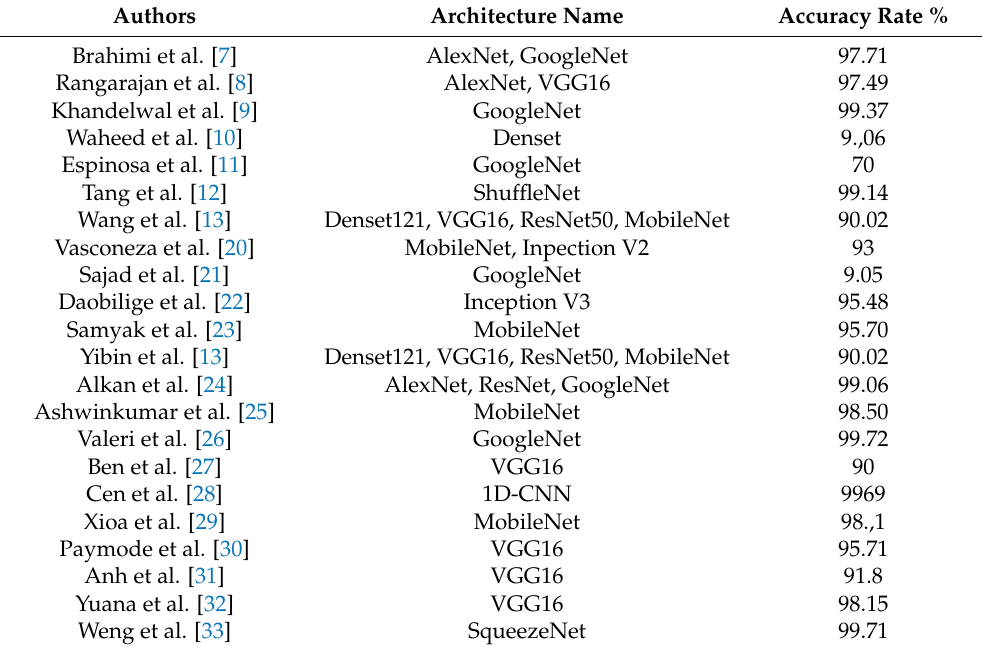
Table 2. Literature’s